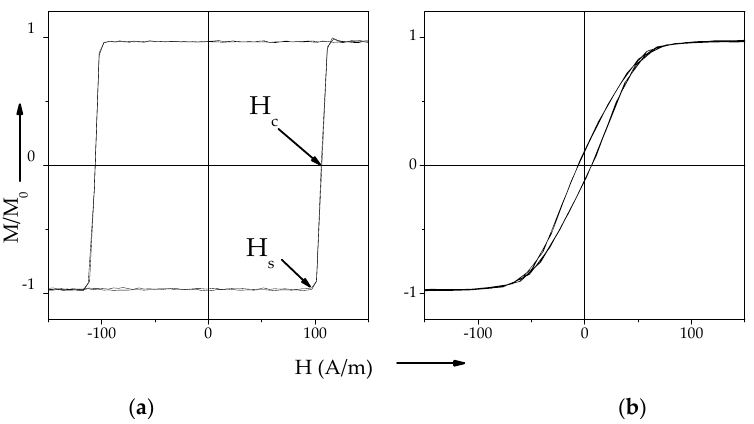
Figure 4. Hysteresis loops of Fe 75 B 9 Si 12 C 4 microwires with positive ( a ) and Co 67 Fe 3.9 Ni 1.5 B 11.5 Si 14.5 Mo 1.6 with vanishing ( b ) magnetostriction coefficients.